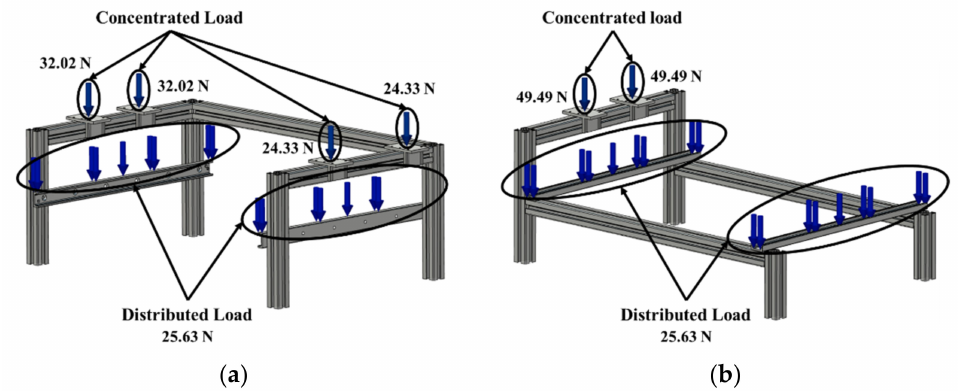
Figure 6. Load Distributions of Automatic Brake Pad Thickness Checking Machine: ( a ) Overhead Crane; ( b ) Cantilever Crane